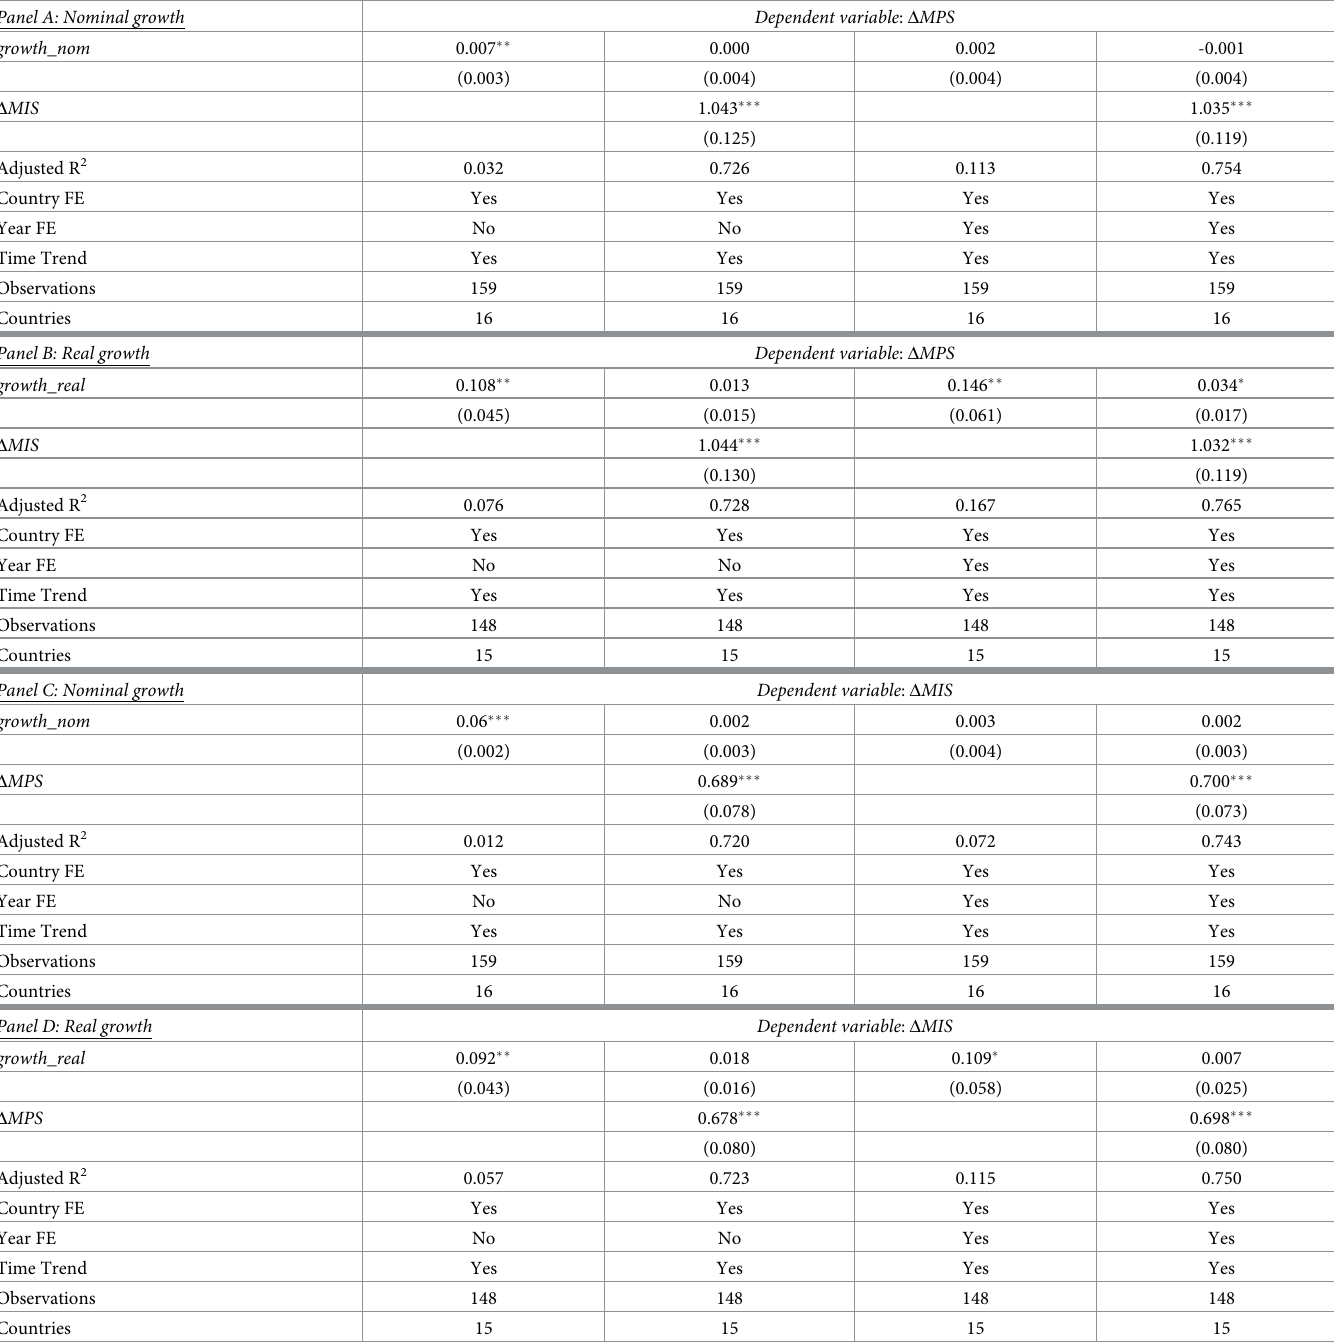
Table 6. Panel regressions of changes in MPS and MIS on mean income growth. Panel A: Nominal